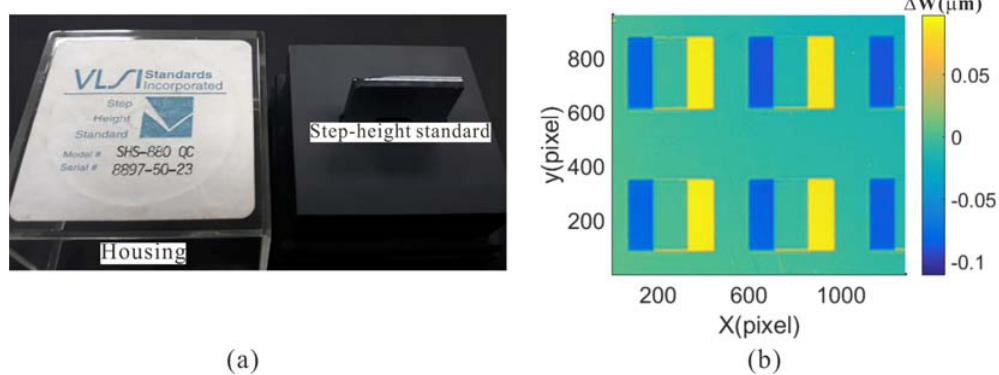
Figure 3. ( a ) VLSI step ‐ height standard; ( b ) measured height variation of step ‐ height